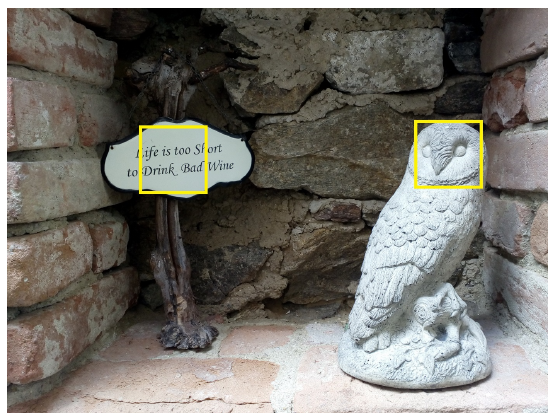
Figure 1. The image with two probable fixation targets (PFTs). It may be assumed that while looking at the image, most of the time people will fixate on one of the regions inside the yellow